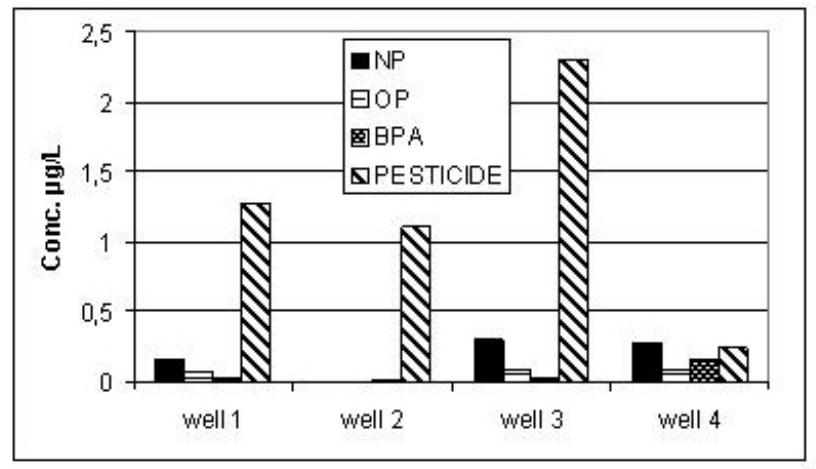
FIGURE 3. Concentration (µg/l) of total herbicides, NP, OP, and BPA in four well samples collected in highly agricultural areas of Catalonia. application in crops. Overall, the presence of such high concentrations of these compounds indicates that groundwater can act as a reservoir of organic pollutants due to the high persistence of these compounds, given by their octanol-water coefficients and low biodegradation